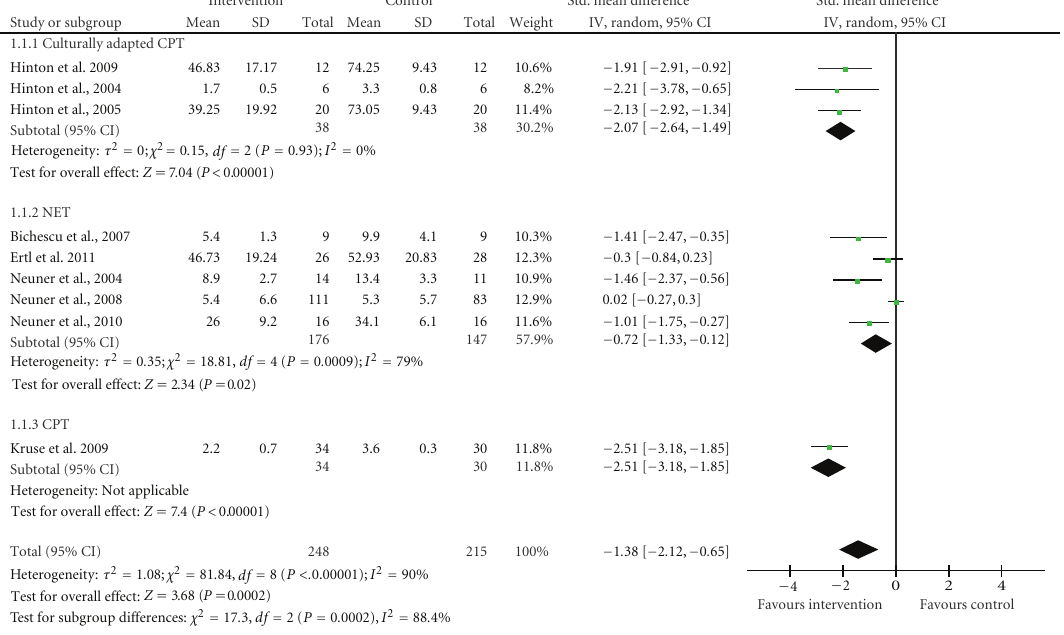
Outcome 2: Depression (Figure 3), Analysis Included Only the Five Trials Which Reported a Depression Score for Their Participants. As indicated in Figure 3, culturallyadapted CPT can successfully help the population of interest reduce the severity of their depression symptoms. The e ff ect size of 6.27 is highly significant at a level of 0.01 ( P < 0 . 00001). Re- garding the PTSD outcome, there is no heterogeneity be- tween the trials ( I 2 = 3%). The e ff ectiveness of NET in the reduction of depression severity is low with an e ff ect size of 1.67, which is not significant at a level of 0.01. However, the test of subgroup di ff erences is significant at a level of 0.01 ( P < 0 . 00008). This indicates that the e ff ectiveness